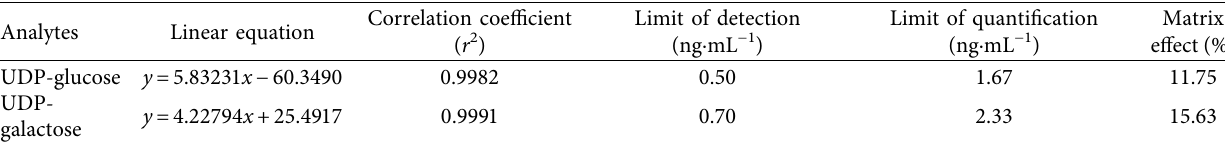
Figure 2: Liquid chromatography-tandem mass spectrometry chromatogram of different concentrations UDP-galactose and UDP-glucose. Table 2: Calibration curves and LOD and LOQ of UDP-galactose and UDP-glucose.